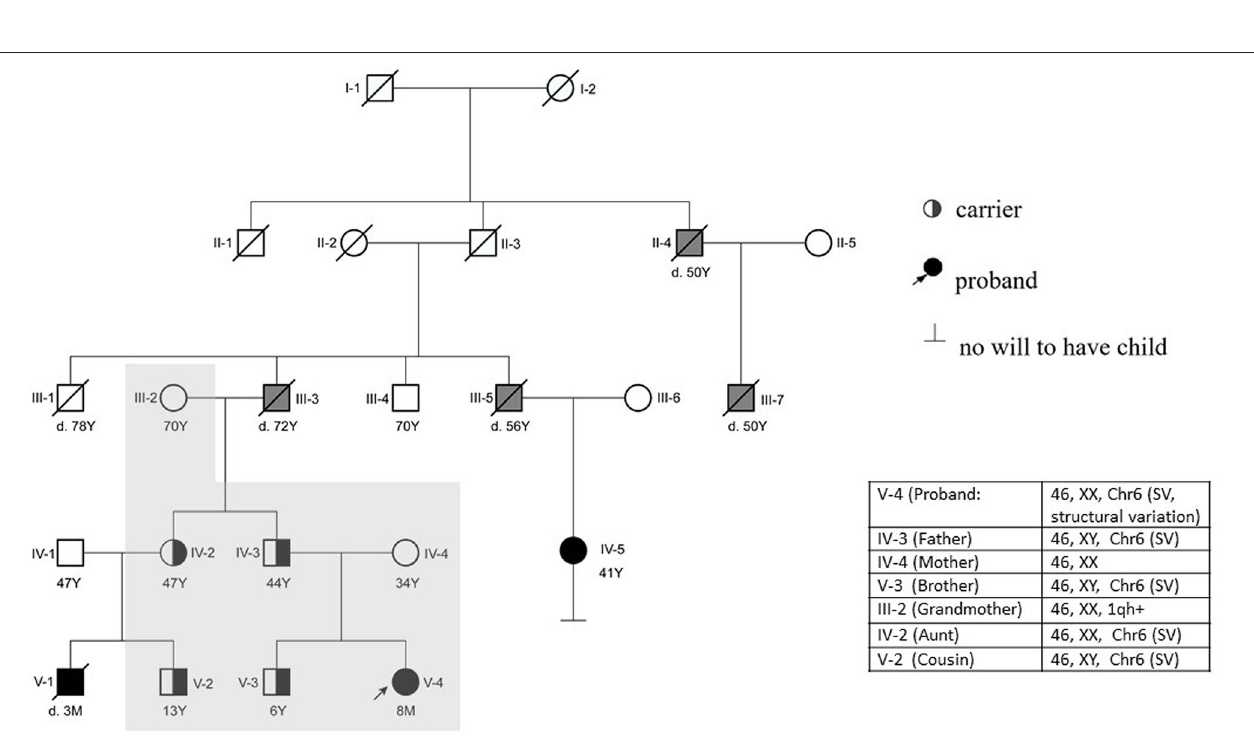
FIGURE 2 | Pedigree of the reported family. The proband (V-4) is indicated with an arrow. The proband’s mother (IV-4) has a normal phenotype. V-1, V-4, IV-5, III-3, III-5, III-7, and II-4 were reported to have cardiac abnormalities. The proband (V-4) had a surgery at 6 months. IV-5 and V-1 were found to suffer from VSD earlier than the proband. V-1 died at 90 days postnatal; IV-5 is alive after she had a surgery 30 years ago. The karyotype of the proband’s father (IV-3), brother (V-3), aunt (IV-2), and cousin (V-2) are the same as the proband’s karyotype. The proband’s grandfather (III-3) and other relatives (II-4, III-5, and III-7) died of heart disease according to information provided by the proband’s father (Y, years; M, month; d.3M, died at the age of 3 months). The individuals with a confirmed VSD are filled in black. The individuals reported to be having other cardiac diseases are filled in gray. The individuals who have done the karyotype examination in this study are indicated with a